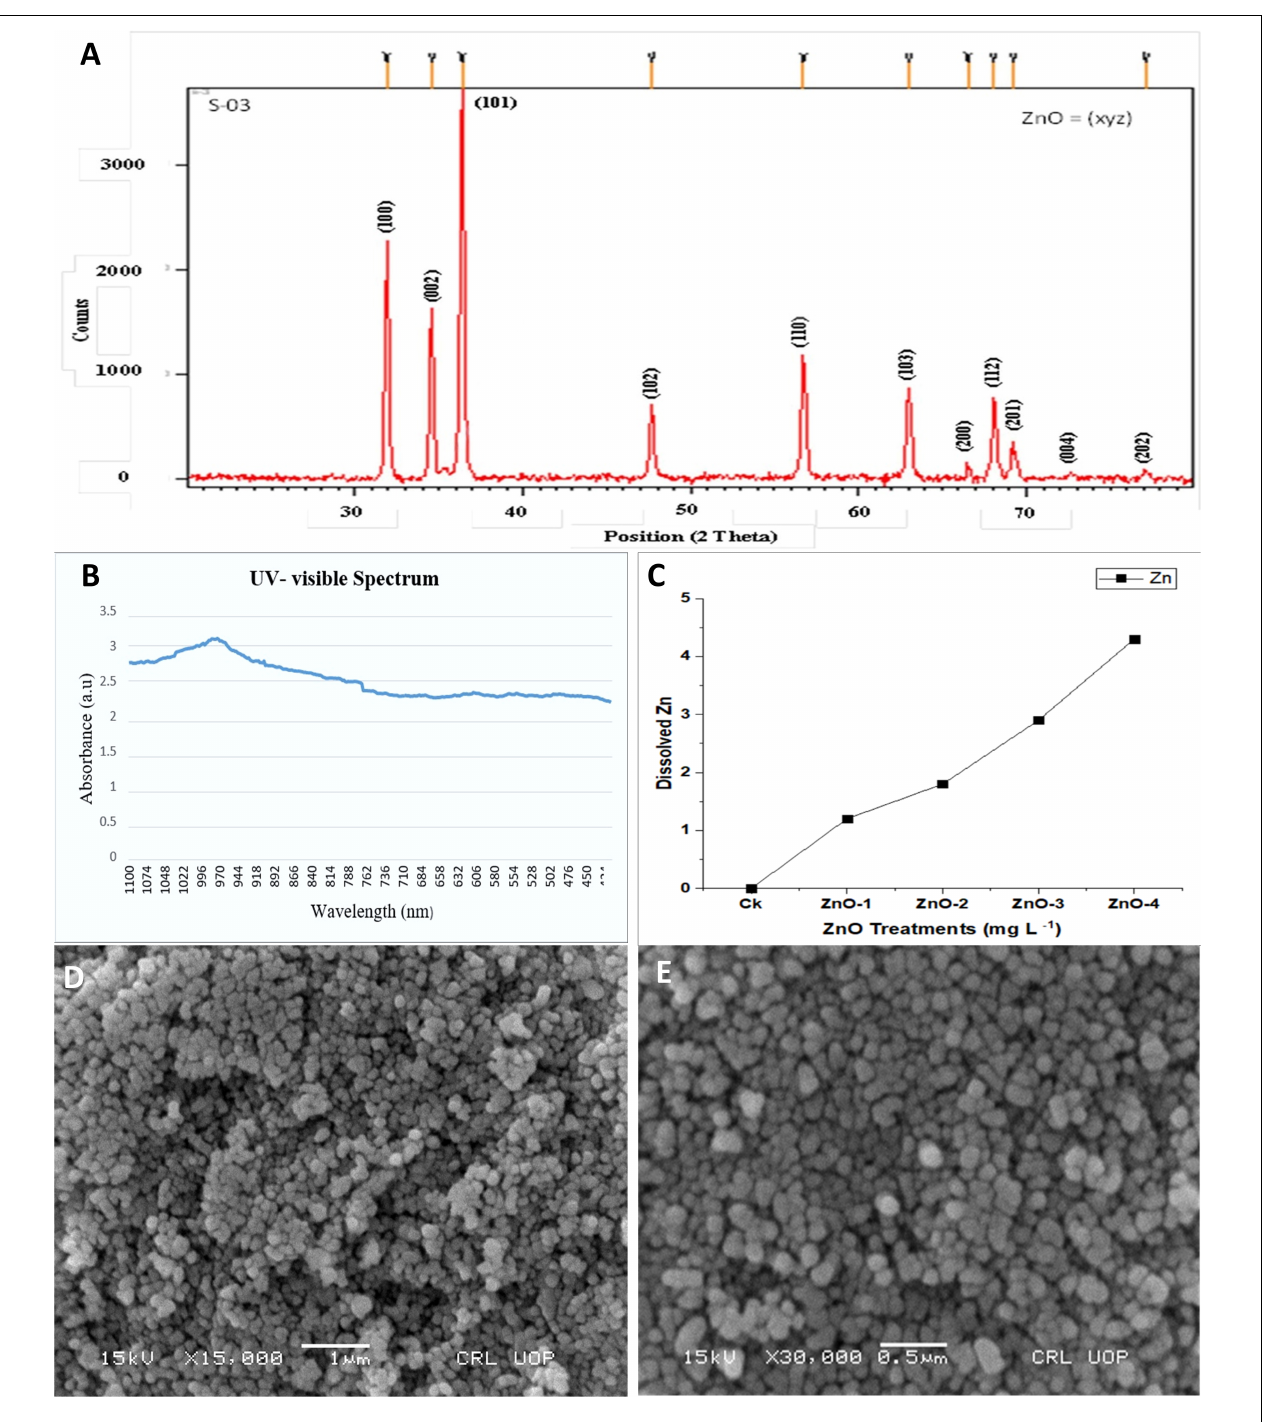
FIGURE 2 | Characterization of zinc oxide nanoparticles (ZnO-NPs) by using (A) X-ray diffraction (XRD) spectra, (B) UV-visible spectrum, (C) nano-ZnO dissolution pattern at different concentration (CK: control, ZnO-1: 15 mg l − 1 , ZnO-2: 30 mg l − 1 , ZnO-3: 45 mg l − 1 , and ZnO-4: 45 mg l − 1 ), and (D,E) Scanning electron microscopy